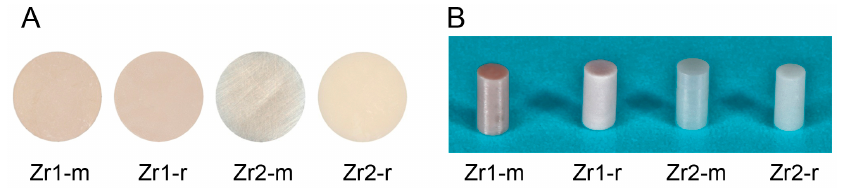
Figure 1. ( A ) Zirconia disks and ( B ) cylindrical rods.